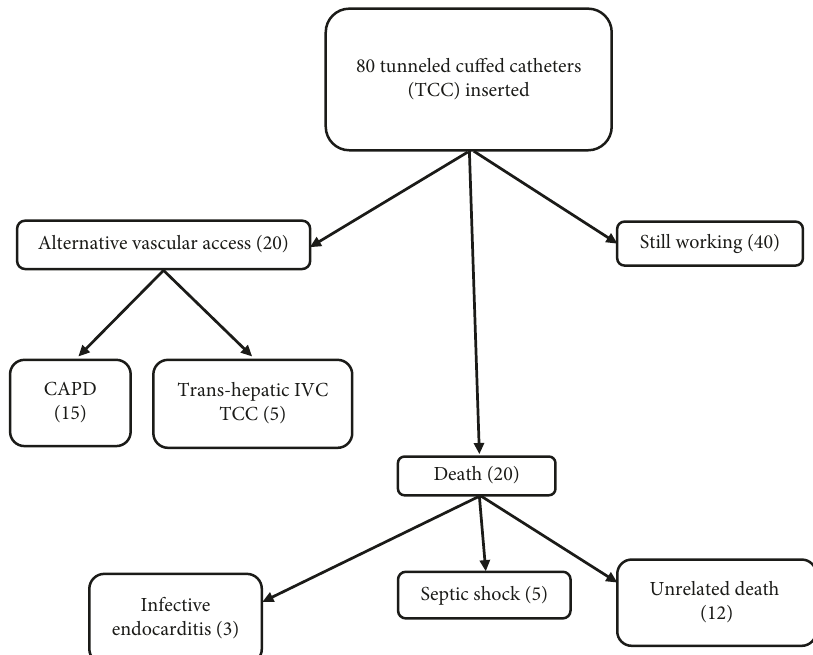
Figure 3: The outcome of cases at the end of the study was as follows, 40 tunneled cuffed catheters were still functioning, and 15 cases were shifted to CAPD. 5 patients were referred to the intervention radiology department for insertion of transhepatic inferior vena caval tunneled cuffed catheters. CAPD: continuous ambulatory peritoneal dialysis; IVC: inferior vena